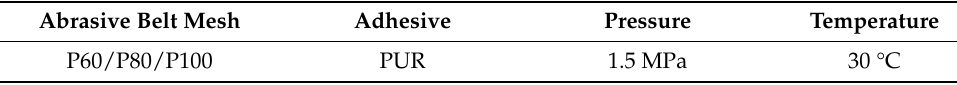
Table 2. Sanding conditions, adhesives, and pressure.